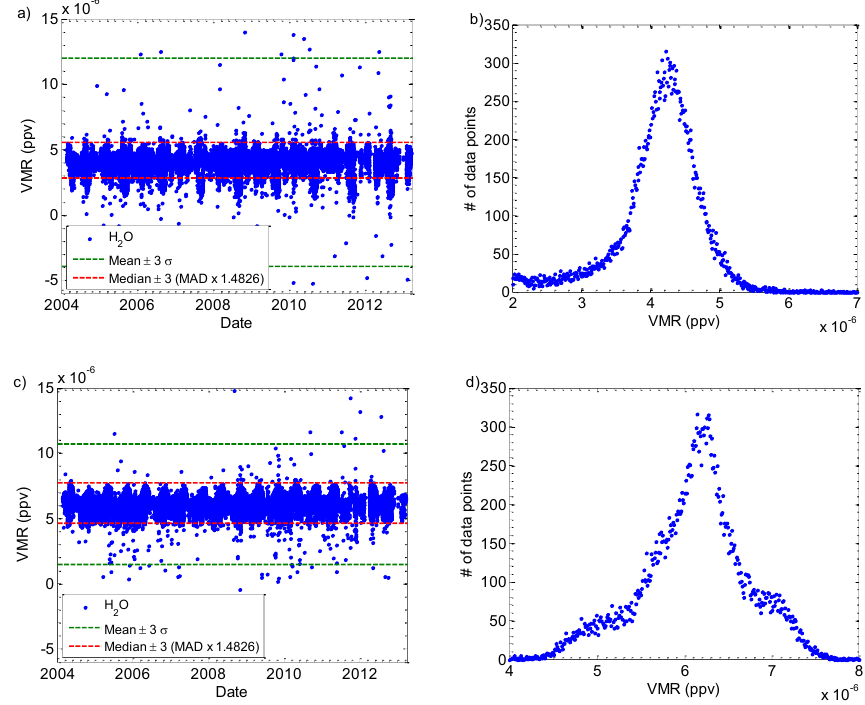
Figure 1. ACE-FTS level 2 v3.5 H 2 O data (left) and corresponding distributions (right). The top panel ( a and b ) shows all data at 17.5km, and the bottom panel ( c and d ) shows all data at